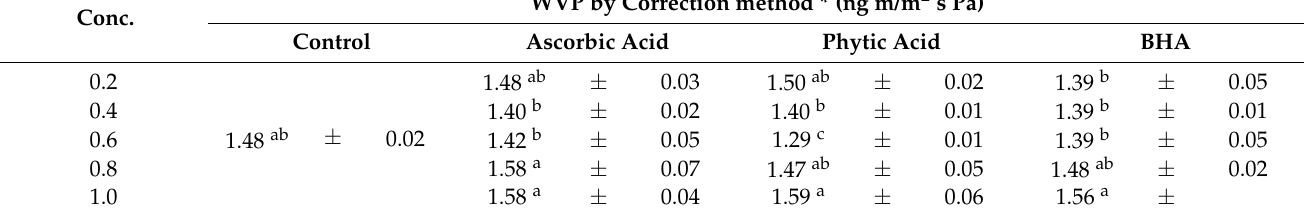
Table 2. Water vapor permeability of GBFs incorporating antioxidants at various concentrations (50% RH, 23 ◦